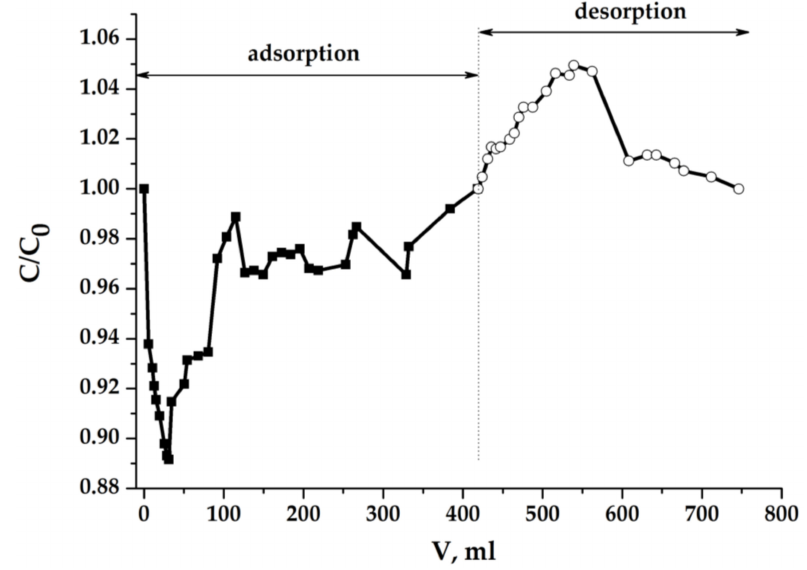
Figure 12. NaCl concentration in the e ffl uent in dynamic process: C 0 = 1 g / dm 3 (0.717 eqv / dm 3 ); U = 1.2 V; porous electrodes: 3 × 3 × 0.5 cm; electrode gap: 0.5 cm; flow rate: 0.69 cm 3 / min.